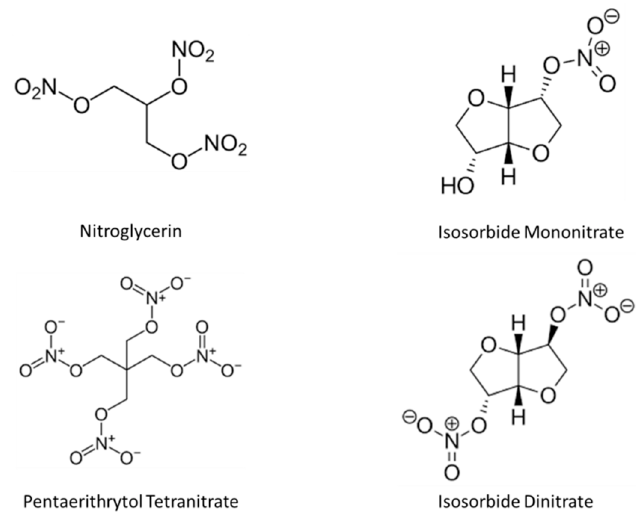
Figure 2. Organic Figure 2. Organic nitrates.